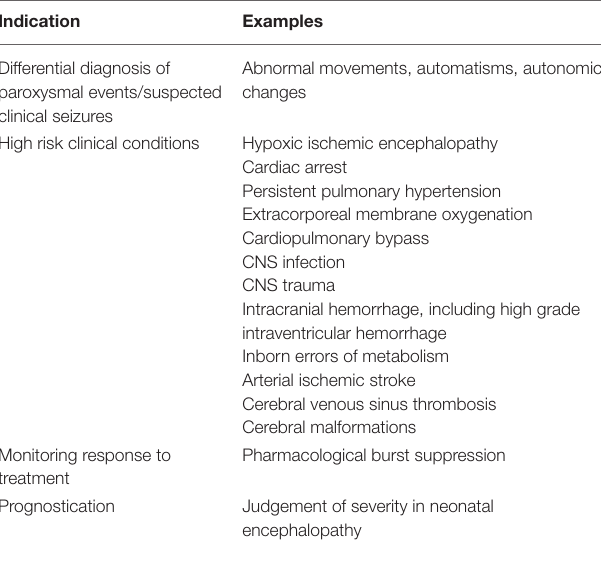
TABLE 1 | Indications for cEEG monitoring in neonates [adapted from Shellhaas, et al. (3)].